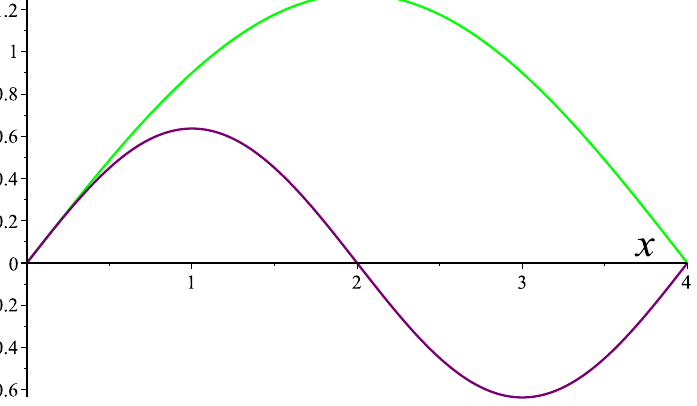
(for Q 0 γ 1 γ 2 1.9 and 1.26 ≈ ≈ (cid:98) (cid:98)